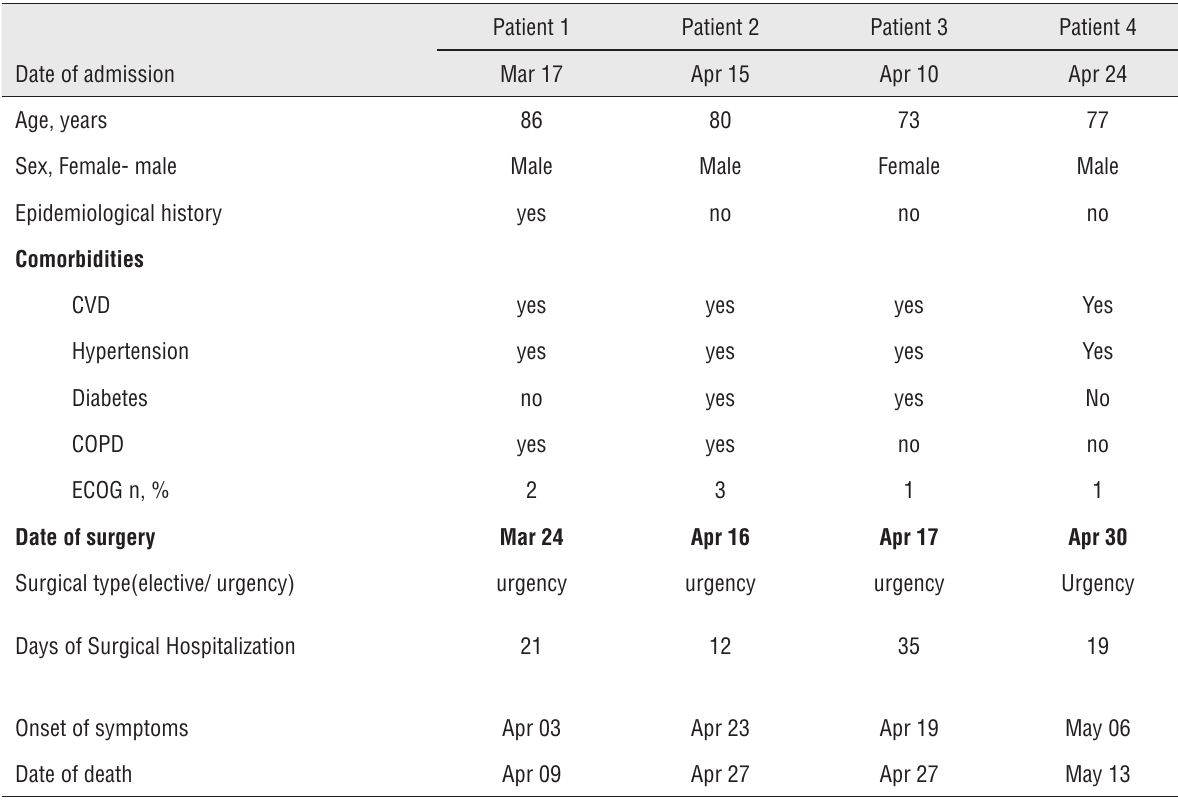
Table 2 - Clinical characteristics of non-survival operative patients with COVID-19